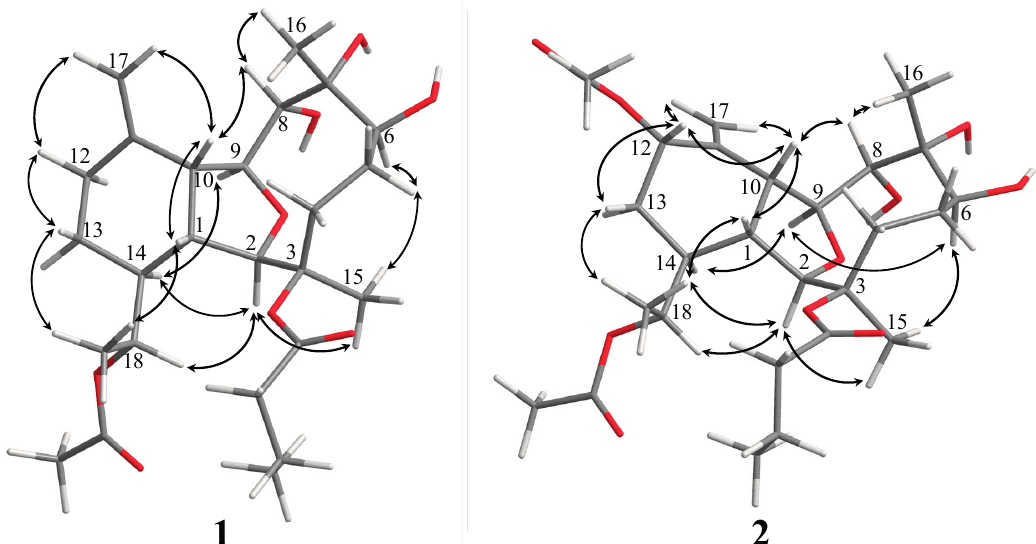
Figure 2. Key NOESY ( ↔ ) correlations for 1 and 2